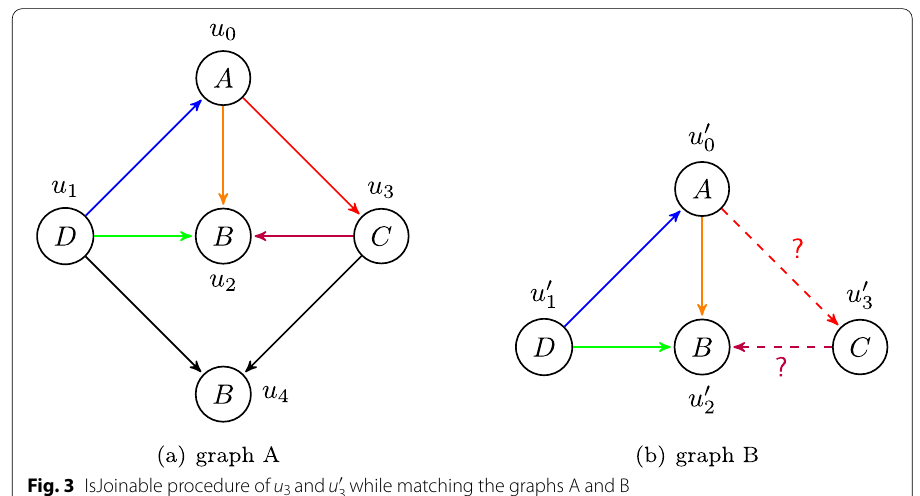
Fig. 3 IsJoinable procedure of u 3 and u ′ 3 while matching the graphs A and